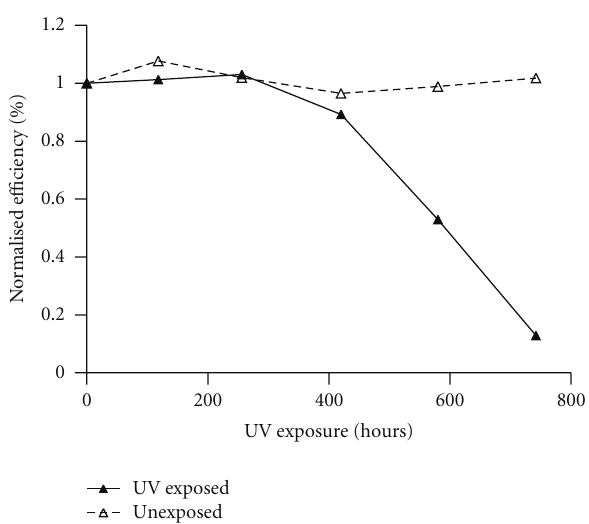
Figure 1: The e ff ect of UV exposure on the % η of DSC test cells compared to that of cells kept in the dark (unexposed).